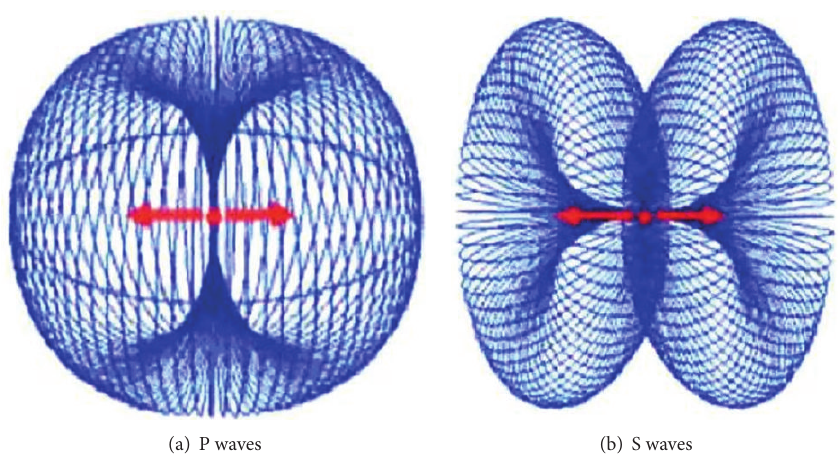
Figure 2: Diagrams of waves propagation from combination of two forces.